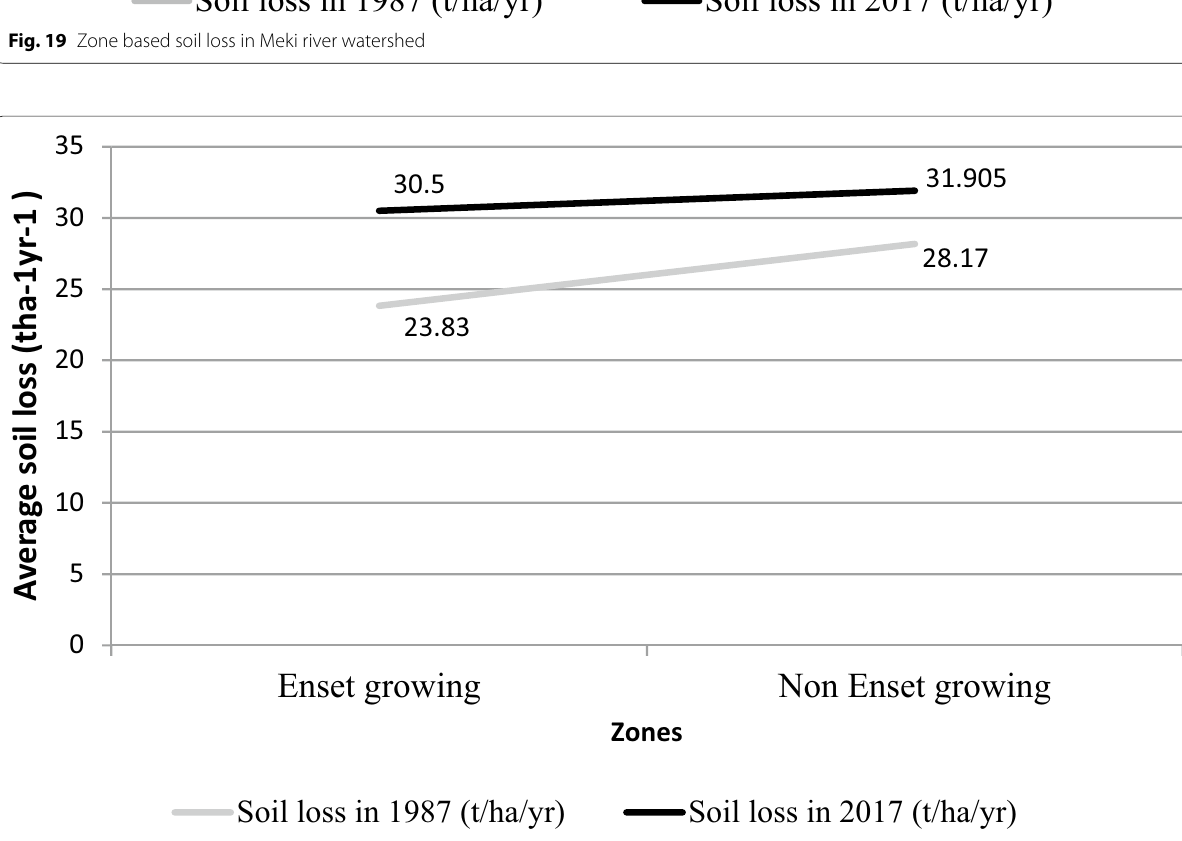
Fig. 19 Zone based soil loss in Meki river watershed